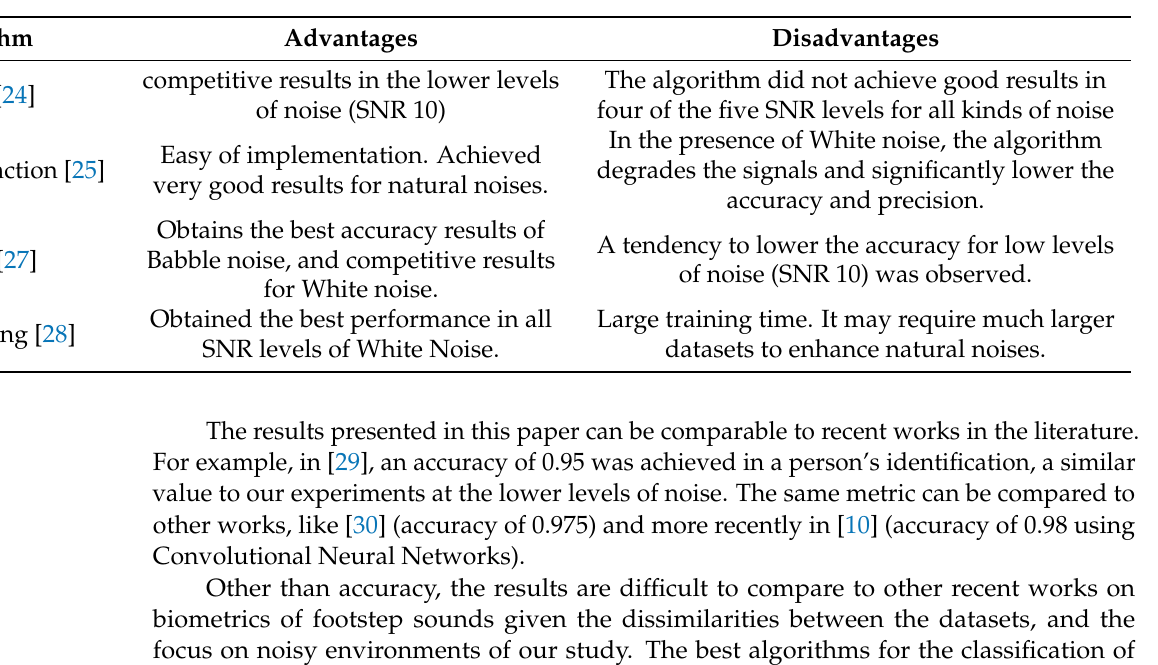
Table 16. Denoising algorithm